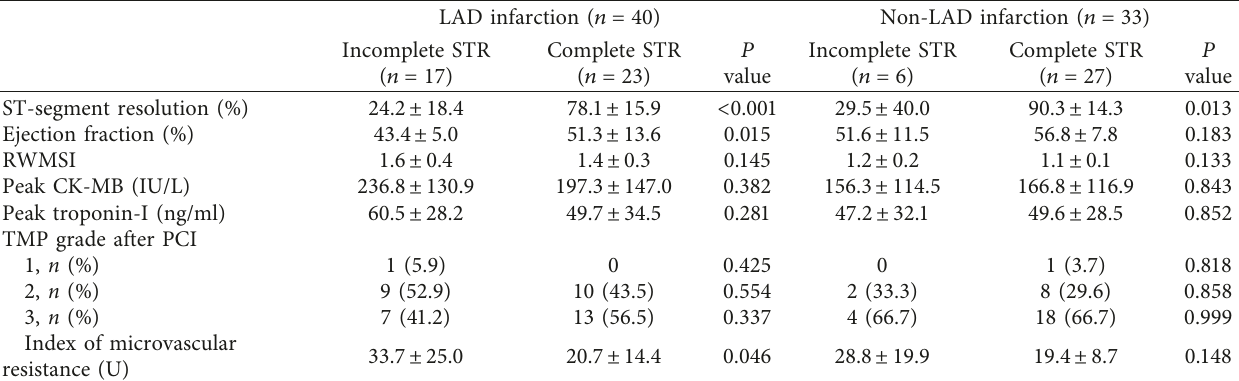
Figure 1: Relationship between STR and IMR. IMR: index of microvascular resistance; STR: ST-segment elevation resolution. Table 2: Comparison of LAD and non-LAD